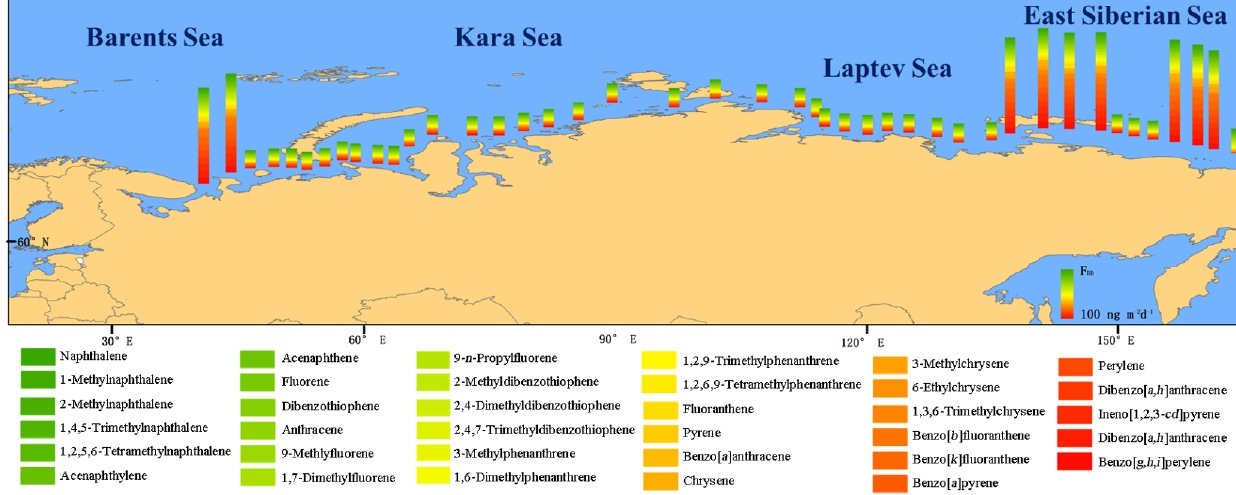
Figure 6. Dry deposition fluxes for the 35 measured PAHs. Color bars indicate the sum of the 35 quantified compounds, and each color represents the individual PAHs in the bottom legend (colors range from red for the heaviest molecular weight PAHs to green for the lightest molecular weight